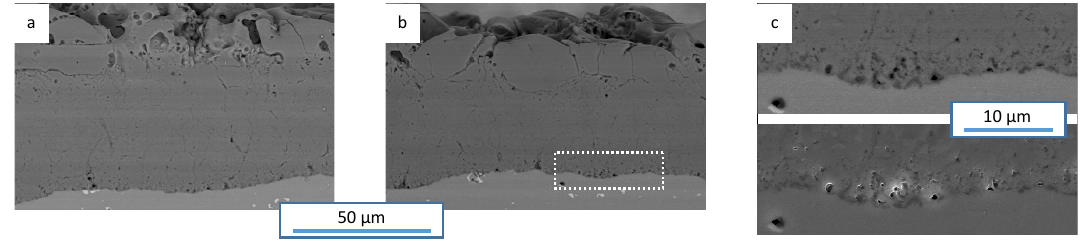
Figure 8. Backscatter SEM images of a sample which was exposed to electrolyte II at cross-sections of the unaffected ( a ) and affected region ( b ), as well as close-ups of the substrate/coating interface in backscatter (top) and seconduray (bottom) electron mode ( c ).